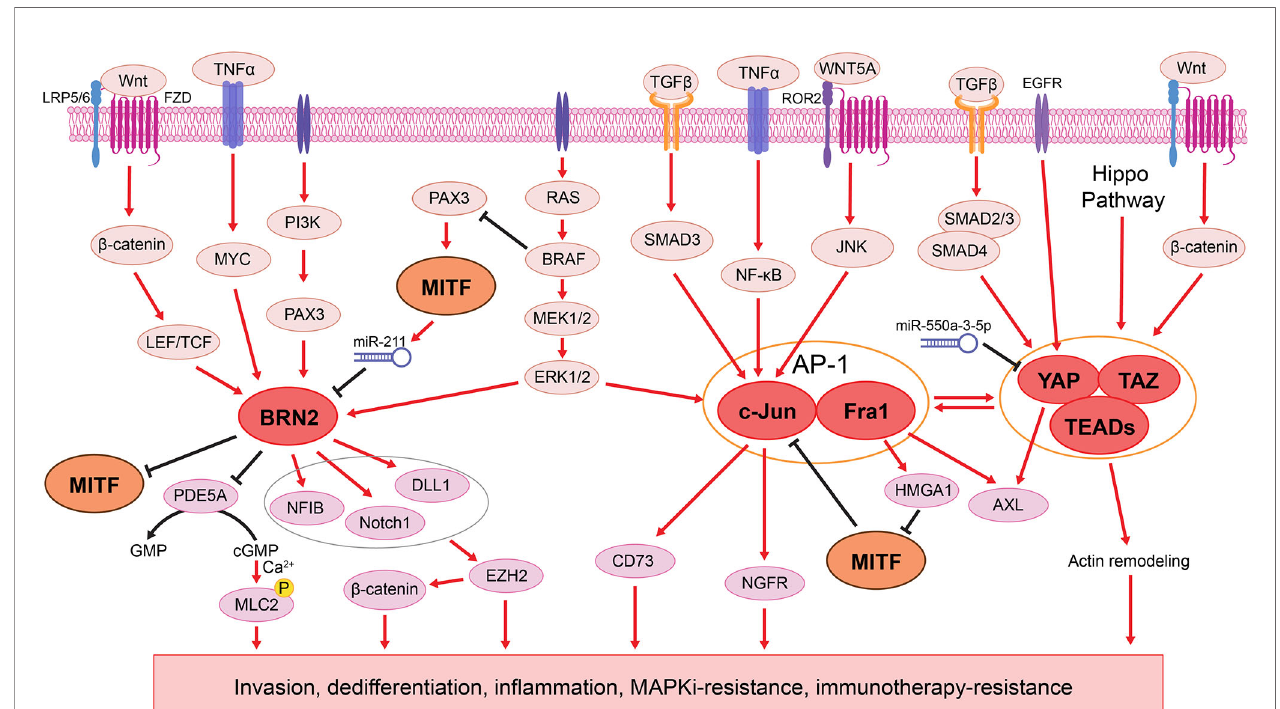
FIGURE 2 | The BRN2 and AP1/TEADs transcriptional networks in melanoma phenotype switching. Left: BRN2 signaling is activated by various pathways, including RAS/RAF/MAPK (106, 107), PI3K/PAX3 (108, 109), Wnt/ b -catenin (110), and TNF a /MYC (111, 112) pathways. BRN2 mediates melanoma cell dedifferentiation by inhibiting MITF transcription (41), while MITF in turn represses BRN2 through miR-211 (44 ) . BRN2 promotes melanoma cell invasion through transcriptional repression of the PDE5A, resulting in accumulated levels of cGMP and ultimately increased cell contractility (106, 107). BRN2 also induces NFIB (113), Notch1, and DLL1 (45), which together promote melanoma phenotype switching through EZH2 (72, 113) and subsequent activation of the WNT/ b -catenin signaling (113, 114). Middle: The AP-1 complex composed of c-Jun and Fra1 is activated downstream of the MAPK pathway (49, 115, 116) and several extracellular ligands, such as TGF b , TNF a and WNT5A (48, 82, 117 – 120). AP-1 suppresses MITF through the Fra1 transcriptional target HMGA1 (53), while MITF binds to the JUN promoter and blocks its transcription (48, 50). AP-1 also upregulates the expression of AXL (48, 53), NGFR (48), and CD73 (104), driving phenotype switching to the invasive and therapy resistant state (49, 121). Right: Downstream of Hippo, TGF b , EGFR, and Wnt/ b -catenin pathways (122), the YAP/TAZ-TEAD complex cooperates with AP-1 to drive melanoma phenotype switching and therapy resistance through AXL and actin remodeling (123 –